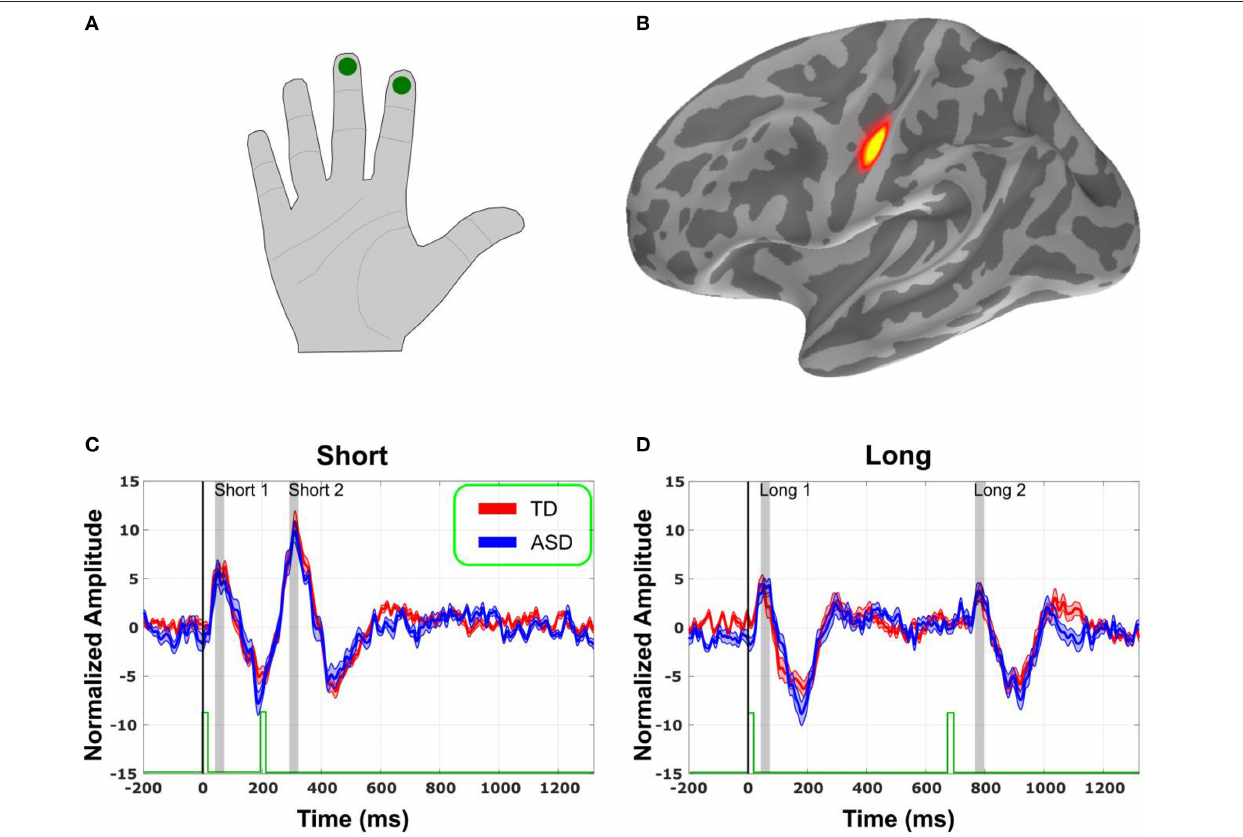
FIGURE 1 | Source localization and Evoked Responses. (A) Schematization of location of stimulus delivery. (B) Evoked responses in sensory space localized to primary Somatosensory (S1) cortex (yellow). (C) Normalized evoked responses in S1 to tactile pulses spaced 200ms (short) apart. Stimulus marked with green bars at the bottom. Shaded gray regions represent the time window of interest, surrounding each peak. Thirty-five to sixty-five milliseconds for peak 1 (short and long), 295–325ms for peak 2 (short), and 760–790ms for peak 3 (long). Shades area around the signal trace is standard error. (D) Same, for the stimuli spaced 700ms (long)